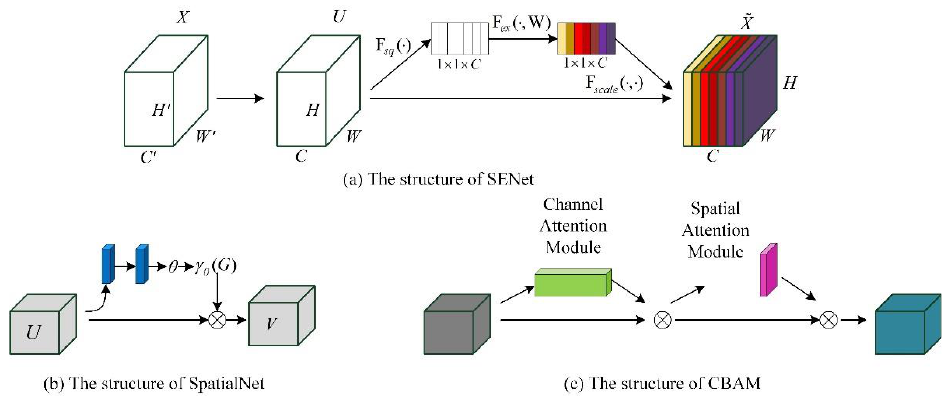
Figure 1. The structure of several typical attention networks. ( a ) represents SENet, which mainly focuses on channel relationship between feature maps, ( b ) represents SpatialNet, which mainly focuses on spatial relationship between feature maps and ( c ) represents CBAM, which focuses on both channel and spatial attention.